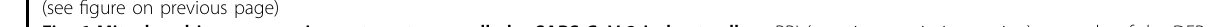
Fig. 6 Mitochondrion was a primary target organelle by SARS-CoV-2 in host cells. a PPI (protein – protein interaction) networks of the DEPs within different sub-cellular compartments in HPAEpiC cells following SARS-CoV-2 infection. The red boxes indicated the DEPs shared in both HPAEpiC and Caco-2 cells following SARS-CoV-2 infection. Data of Caco-2 cells (24 h after infection) was from published literature by Bojkova et al. 26 . Proteins differentially expressed in Caco-2 (24 h post infeciton) with fold change over 1.3 and p < 0.05 were identi fi ed as DEPs (Supplementary Table 3). The color represents the log 2 ratio. PPI network was constructed based on STRING database with the interaction score set to high con fi dence (0.700). b Western blot was performed to analyze the protein levels of TIMM23 and NDUFA4 in mock- and SARS-CoV-2-infected HPAEpiC cells. The result is a representative blot from three independent experiments. c Confocal fl uorescent images of Mock- or SARS-CoV-2-infected HPAEpiC cells stained by mitoSox Red dye. Viral Spike protein indicated the infected cells. d , e Culture supernatants of HPAEpiC cells or HULEC-5a cells were harvested at indicated time points following SARS-CoV-2 infection to examine the extracellular ROS level using an ELISA kit for different groups. The results represent three independent experiments. Data were presented as mean ± SEM. The extracellular ROS level of mock-infected group at each time point was normalized to 1. f Heatmap showed the up-regulated proteins related to responses to oxidative stress in HPAEpiC cells following SARS-CoV-2 infection. Color indicates the abundance of a protein. All up-regulated proteins were searched based on GO annotation keywords (response to oxidative stress or response to reactive oxygen species). Fold change >1.5, P -value < 0.05 in ( d